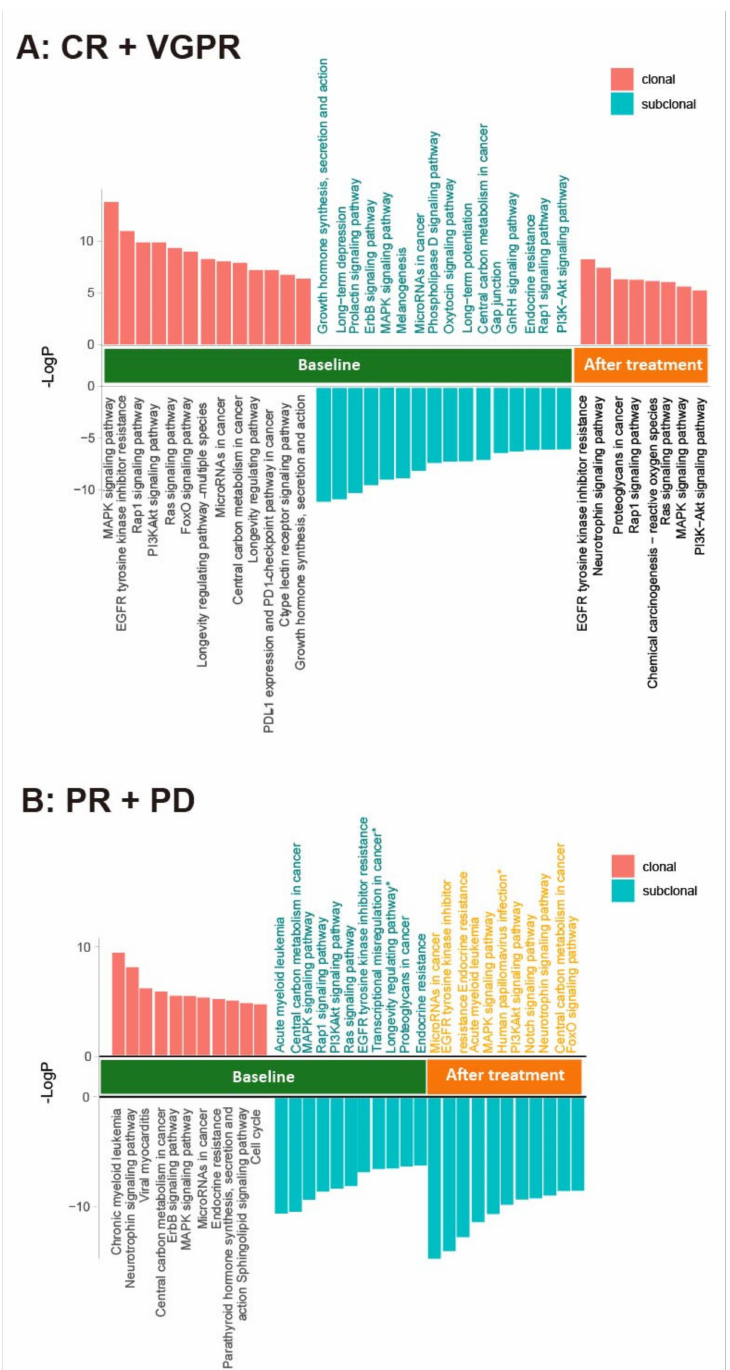
Figure 8. Involved pathways enriched in the clonal and subclonal mutations in ctDNA before and after treatment for ( A ) CR + VGPR; ( B ) PR + PD. PyClone was used to analyze the clonal population structures in baseline ctDNA and post-treatment ctDNA samples. The copy number information of each SNV was used as input. For each clustering process, a PyClone algorithm was run for 20,000 iterations with a burn-in of 2000, using a beta-binomial model with the “total_copy_number” option (Murtaza M, Dawson SJ, Pogrebniak K, Rueda OM, Provenzano E, Grant J et al. Multifocal clonal evolution characterized using circulating tumor DNA in a case of metastatic breast cancer. Nature communications. 2015; 6: 8760.) [25]. To clarify the functional role of clonal and subclonal genes, we performed pathway enrichment analysis in the mutations detected in before and after treatment